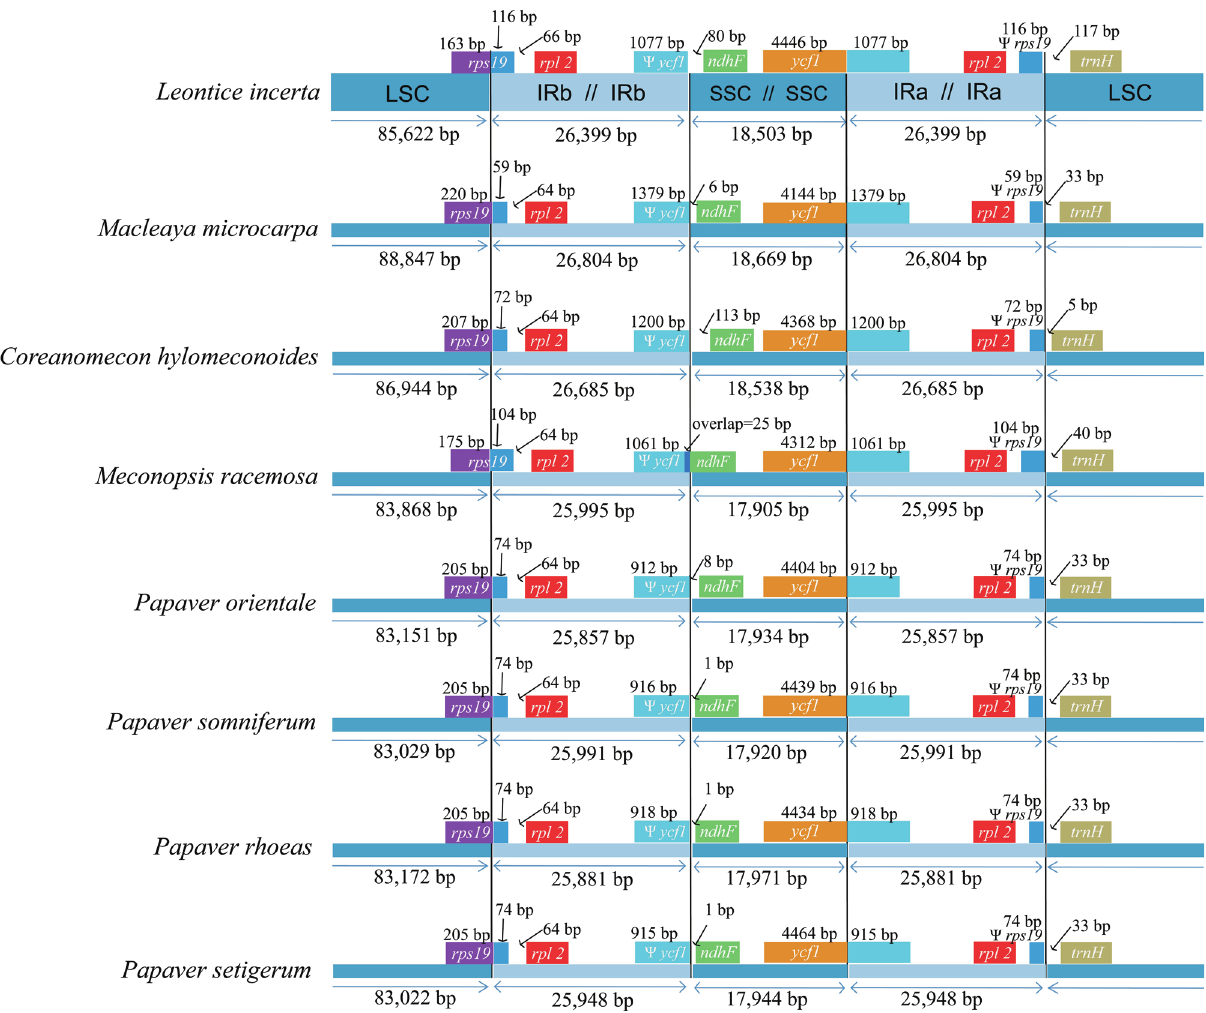
Figure 4 - Comparison of the borders of large single-copy (LSC), small single-copy (SSC), and inverted repeat (IR) regions among the seven Papaveraceae chloroplast genomes, with the Leontice incerta cp genome shown at the top as the